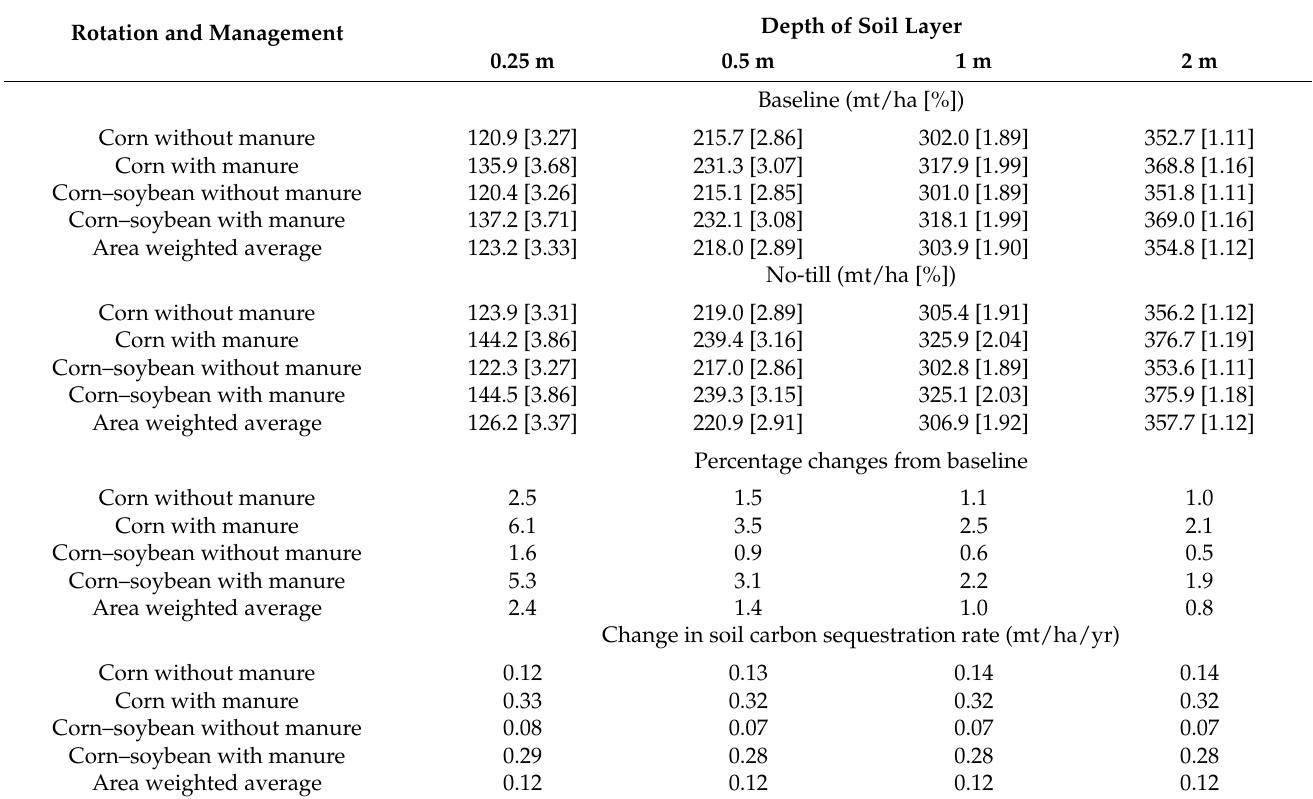
Table 7. Conservation tillage impacts on soil organic